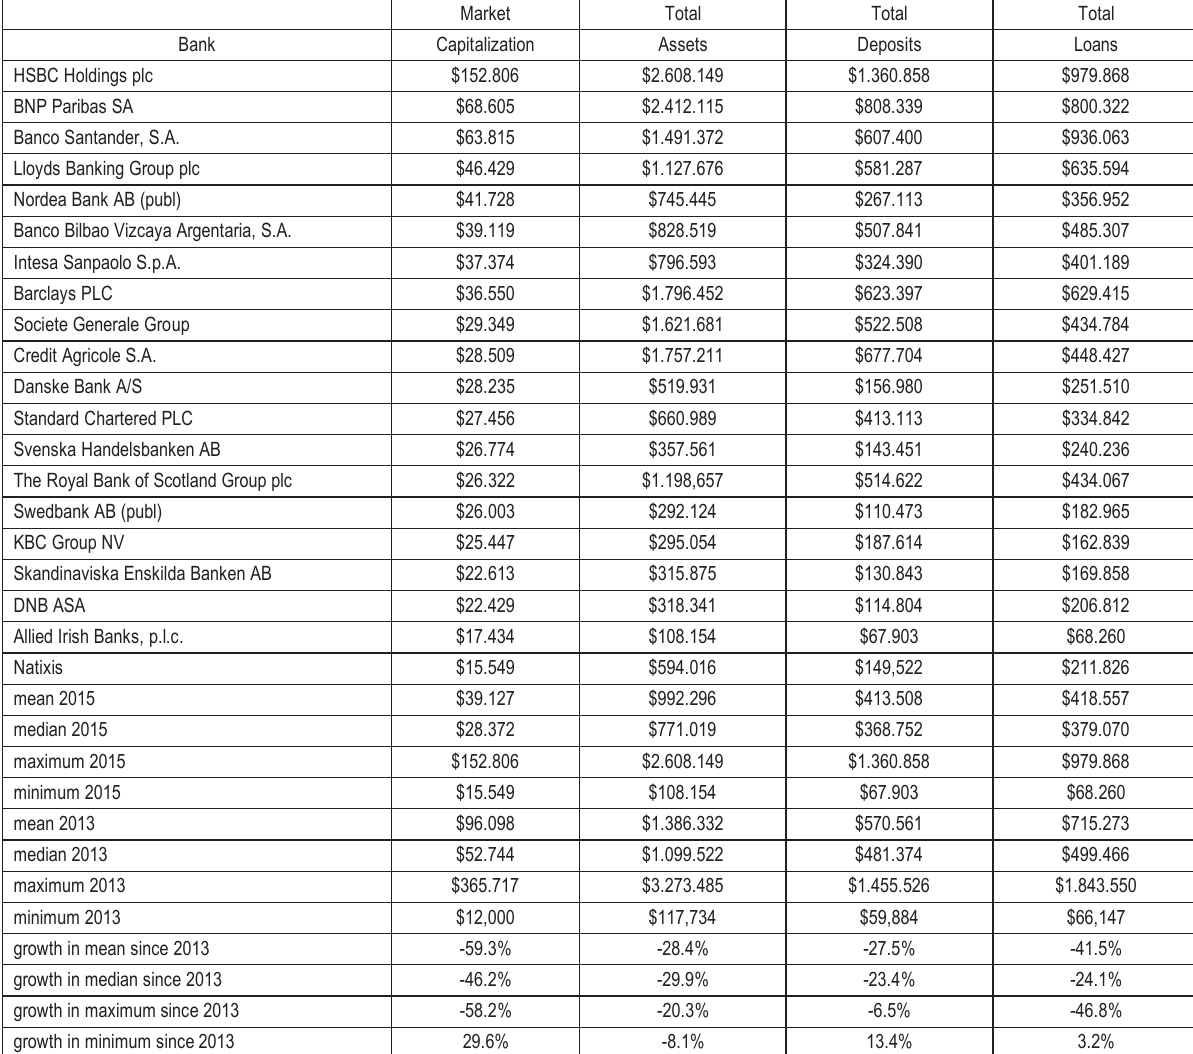
Table 2. Descriptive Statistics. Largest 20 European Banks (in terms of market capitalization) designated